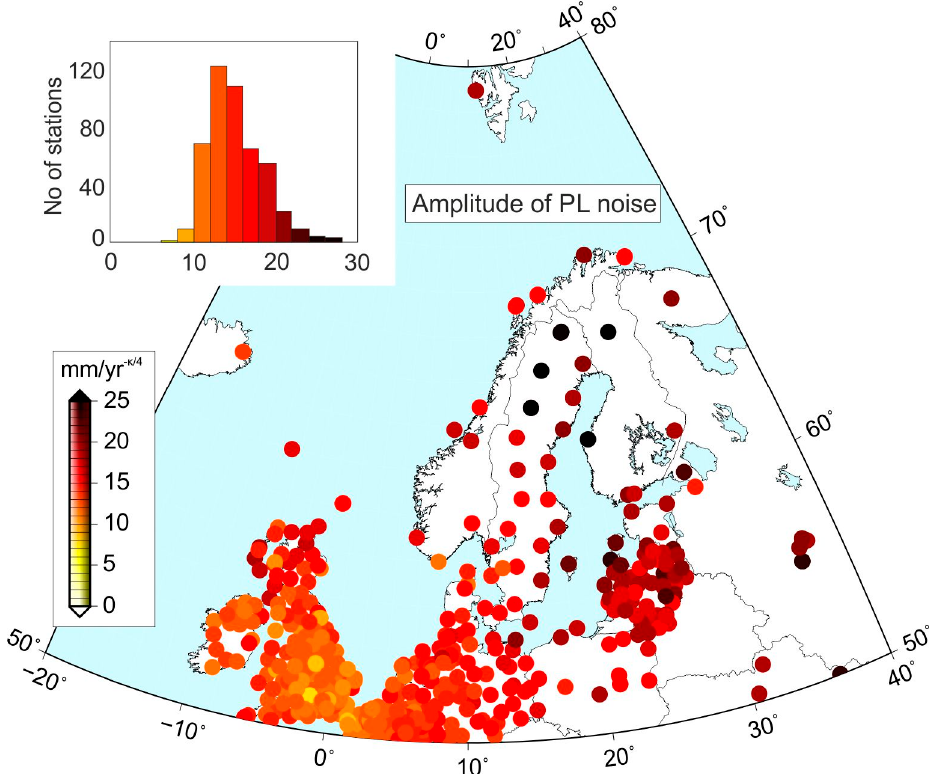
Figure 6. The amplitudes of power-law noise (in mm / yr − κ / 4 ) for the 469 European GPS stations. The amplitudes are estimated for the white plus power-law noise assumption and computed with the MLE approach.